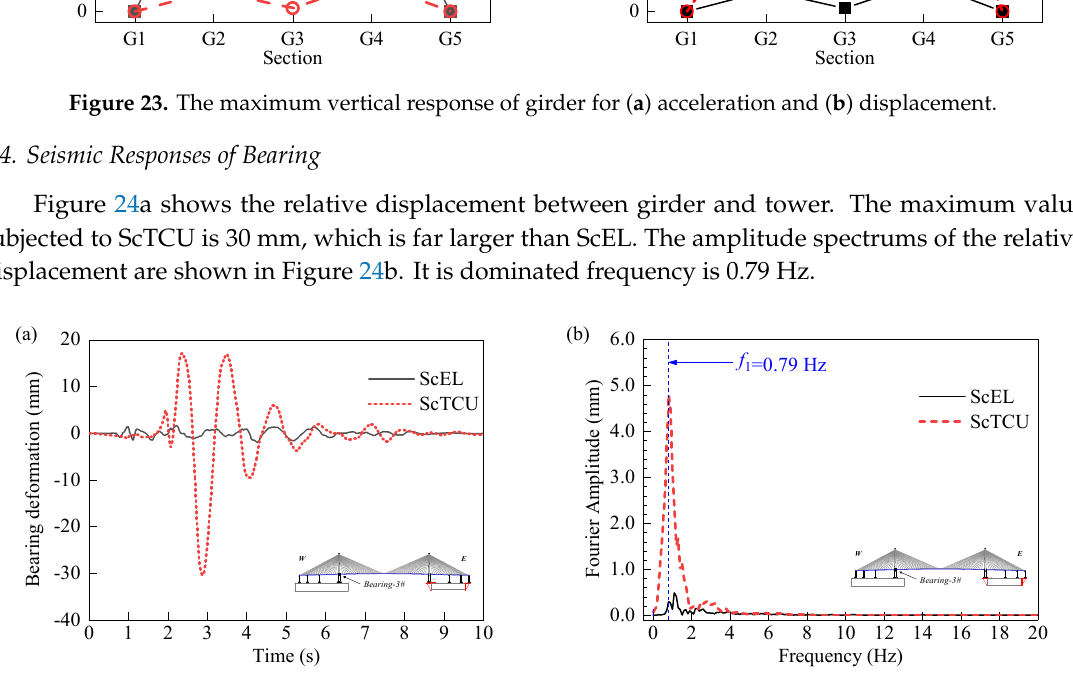
Figure 24. Longitudinal displacement of tower and girder on bearing connection ( a ) Bearing relative displacement ( b ) Fourier Amplitude.